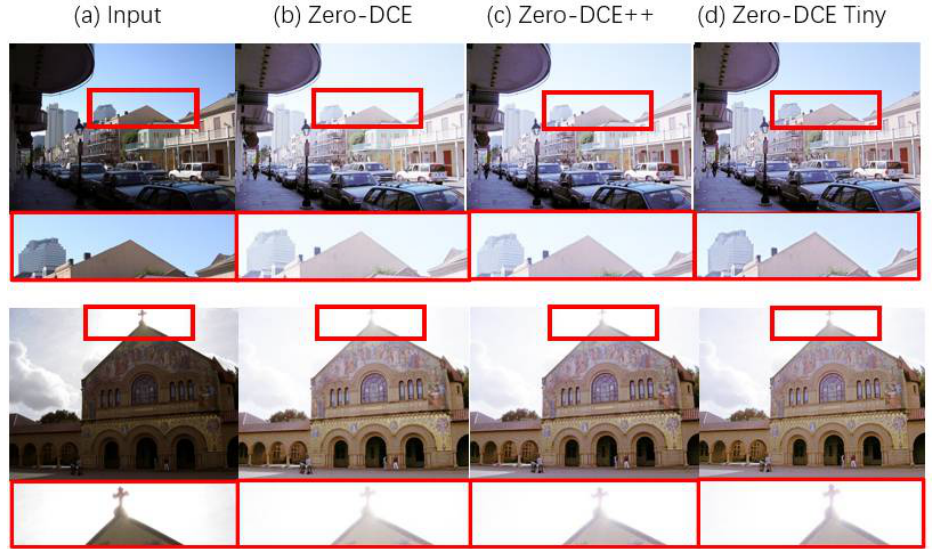
Figure 9. Visual comparisons among the results generated by the Zero-DCE series of methods. Subfigure ( a ) shows the original input, subfigure ( b – d ) respectively shows the enhanced image results through Zero-DCE [5], Zero-DCE++ [6] and Zero-DCE Tiny methods.